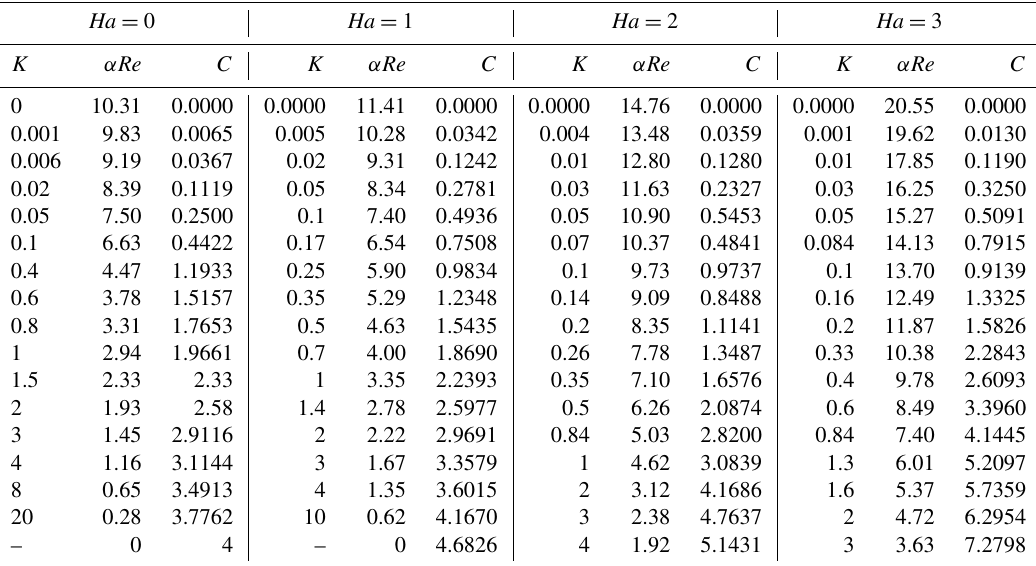
Table 2. The C values corresponding to α Re , K and Ha number.